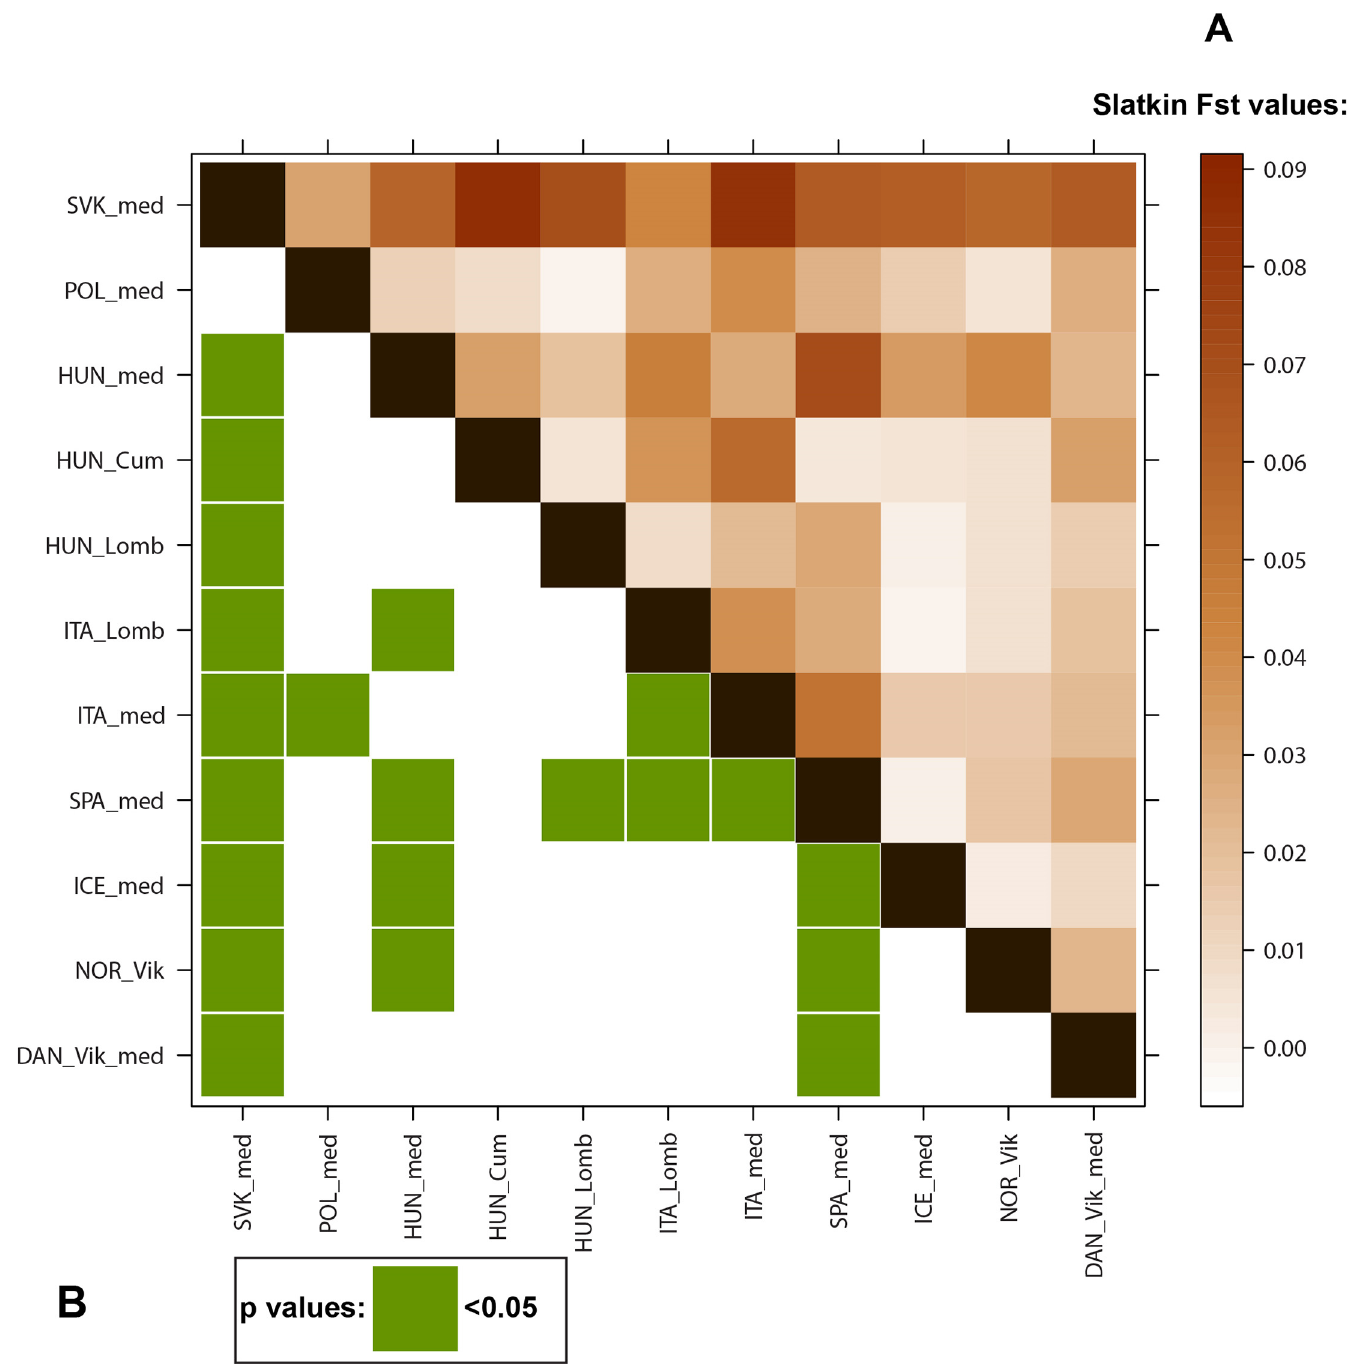
Fig 2. Levelplot of the linearized Slatkin population differentiation (F ST ) values and significant p values. (A) Levelplot of the linearized Slatkin F ST values of the European medieval populations. (B) significant p values ( < 0.05) are indicated in green. The exact F ST and p values and population information can be found in S6